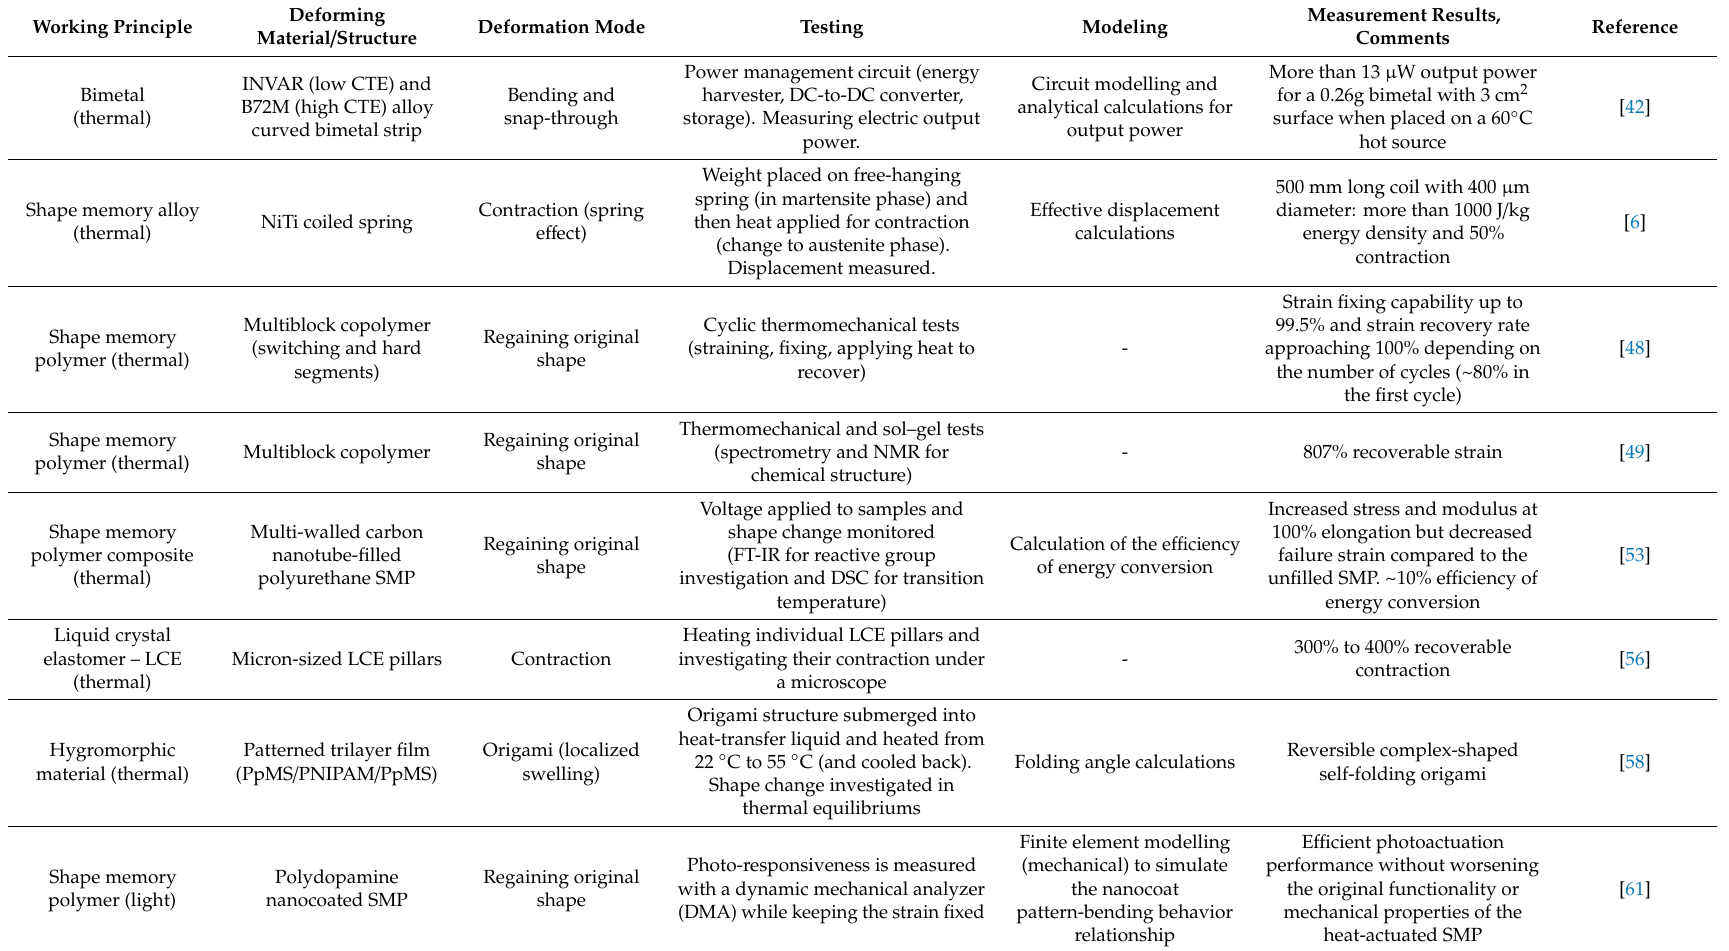
Table 2. Heat-, light-, pressure- and chemically actuated non-conventional